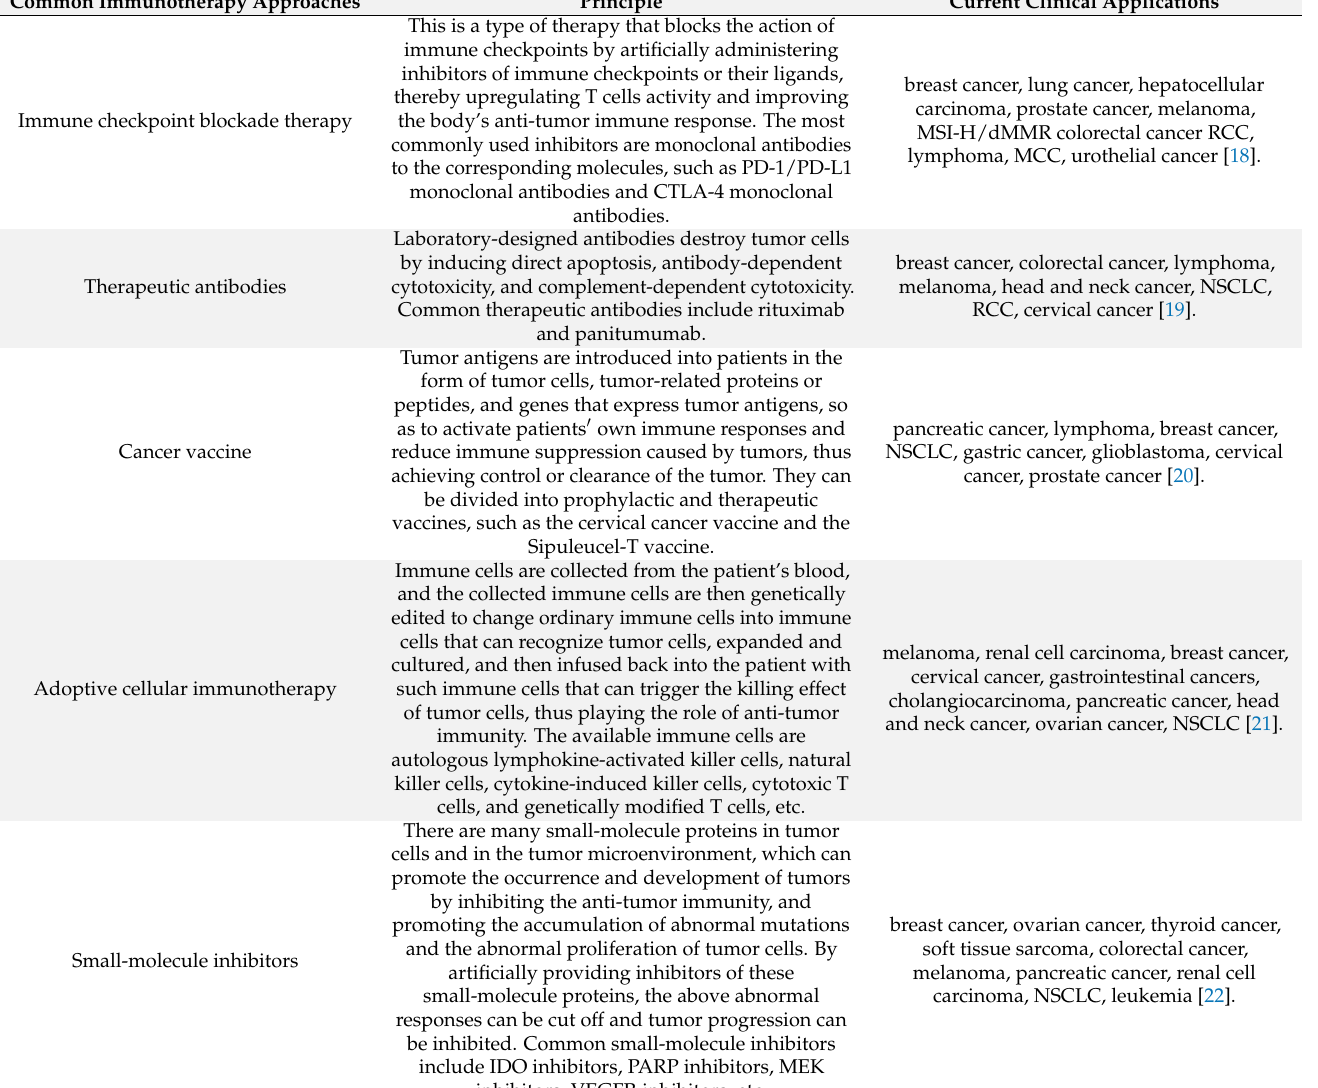
Table 1. Common immunotherapy